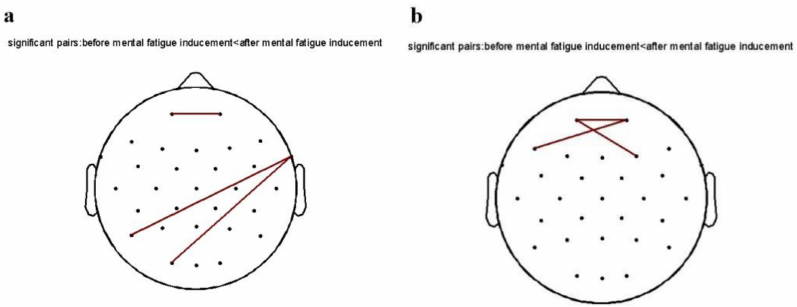
Figure 6. Diagram of the functional connection of the 240 Hz pure tone group in the eyes-opening state: ( a ) theta band; ( b ) alpha